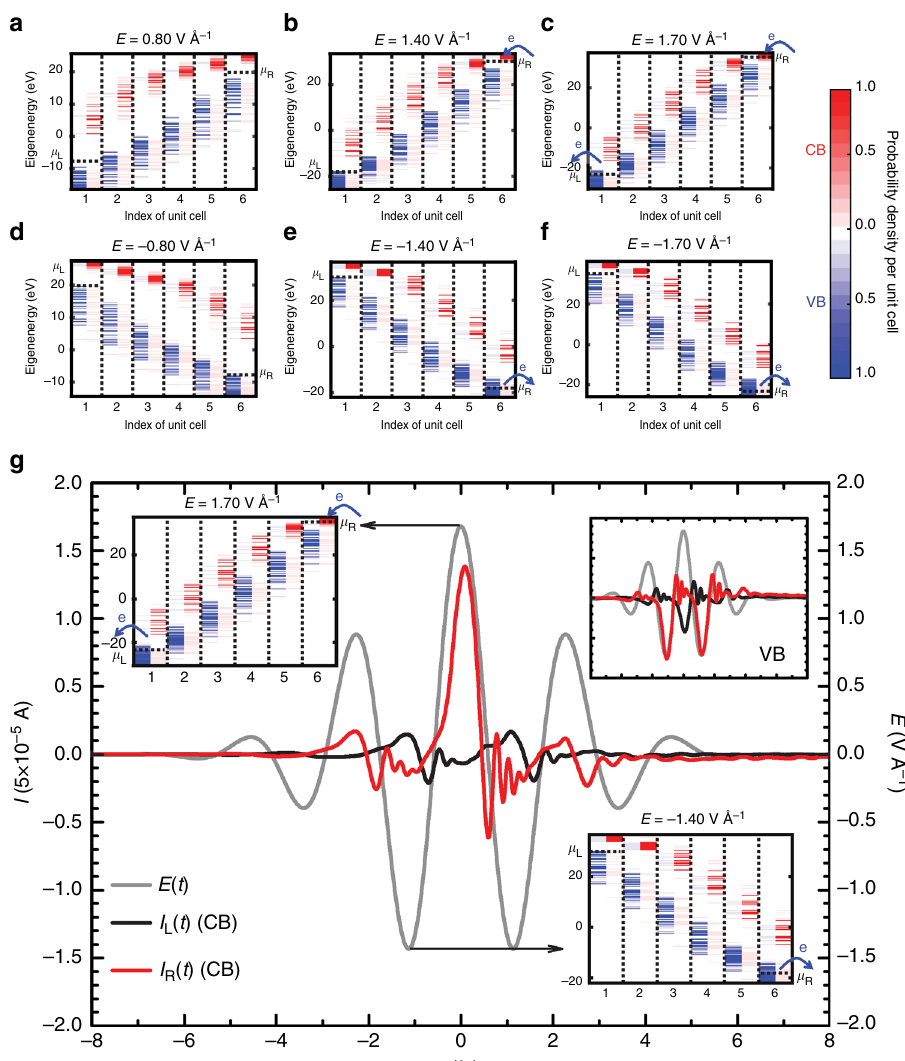
Fig. 8 Mechanism underlying the laser-induced currents. a – f Laser-dressed single-particle eigenstates of SiO 2 ( N = 6, E || a , μ F = 6.0 eV) for different laser fi eld amplitudes. The plots show the eigenenergies and probability density distribution of the eigenstates along the junction. In each unit cell, the population of each eigenstate is divided into a contribution due to the Wannier functions that form the VB (blue) and CB (red). For a given E ( t ), current can only fl ow through the junction when the Wannier-Stark states at the terminal ends are properly energetically aligned with the lead ’ s chemical potential. Speci fi cally, the terminal Wannier functions associated with the CB (or VB) need to be below (or above) the chemical potential for silica-metal charge exchange. The blue arrows indicate the fl ow of electrons. Only for E > 1.4 V Å − 1 transport channels are open and signi fi cant current can be observed. g Currents entering the left ( I L , black) and right ( I R , red) contact during the photoinduced dynamics of the junction induced by E ( t ) with φ = π (in gray). The main plot shows the contribution due to the CB to the total current (electron transport) and the top-right inset that of the VB (hole transport). The energies and spatial probability distribution of the laser-dressed eigenorbitals for maximum and minimum laser amplitude are shown at the top-left and bottom-right corners, respectively. Net phase-controllable currents arise due to a difference in effective coupling between SiO 2 and the metallic contacts for negative and positive fi eld amplitude. In the CB, a burst of charge from the metal is observed around the central peak of the pulse for positive amplitude where charge injection